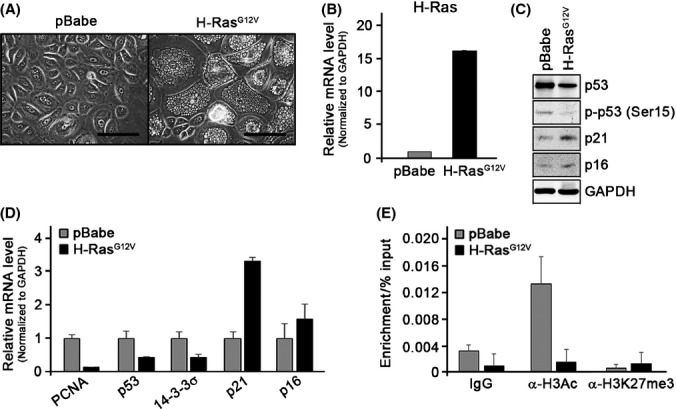
p53 expression decreases during oncogene-induced premature senescence via H3 deacetylation. (A) Actively proliferating normal human keratinocytes (NHKs) were infected with retrovirus expressing empty vector (pBabe) or H-RasG12V and selected using puromycin (1 μg mL−1). The bar represents 100 μm. (B) Cells were collected 6 days after infection, and overexpressed H-Ras mRNA levels were confirmed using qRT–PCR. Western blotting (C) and qRT–PCR (D) were performed on these cells. (E) ChIP assay was performed in NHKs with pBabe or H-RasG12V using anti-H3Ac and anti-H3K27me3 antibodies.